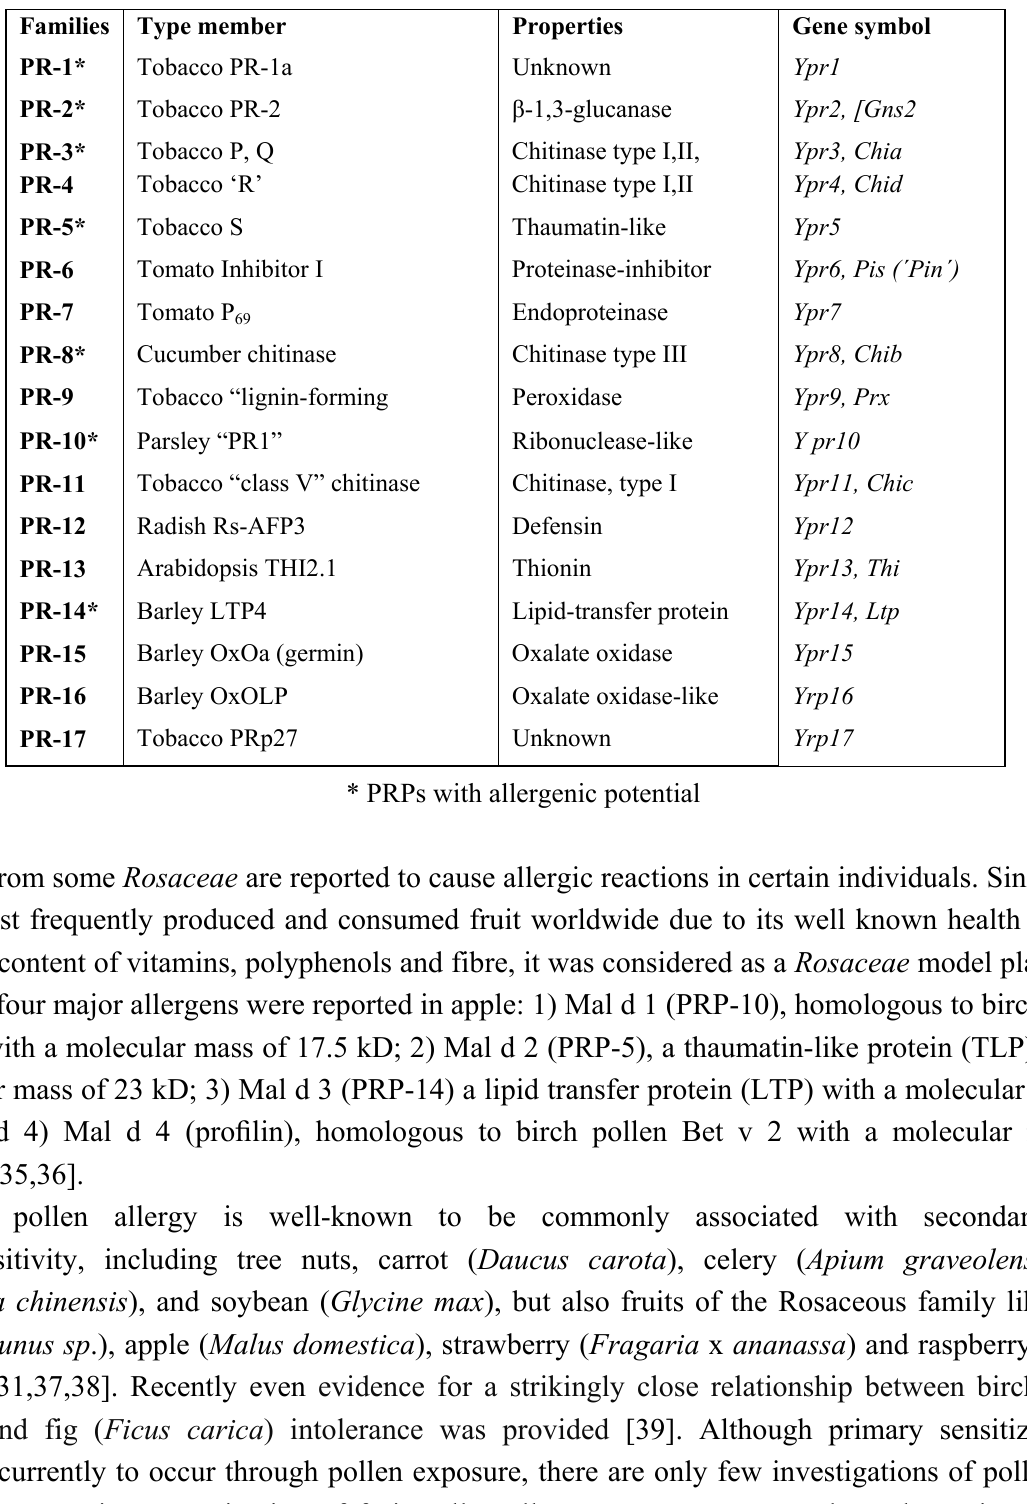
Table 1. Families of PR proteins according to